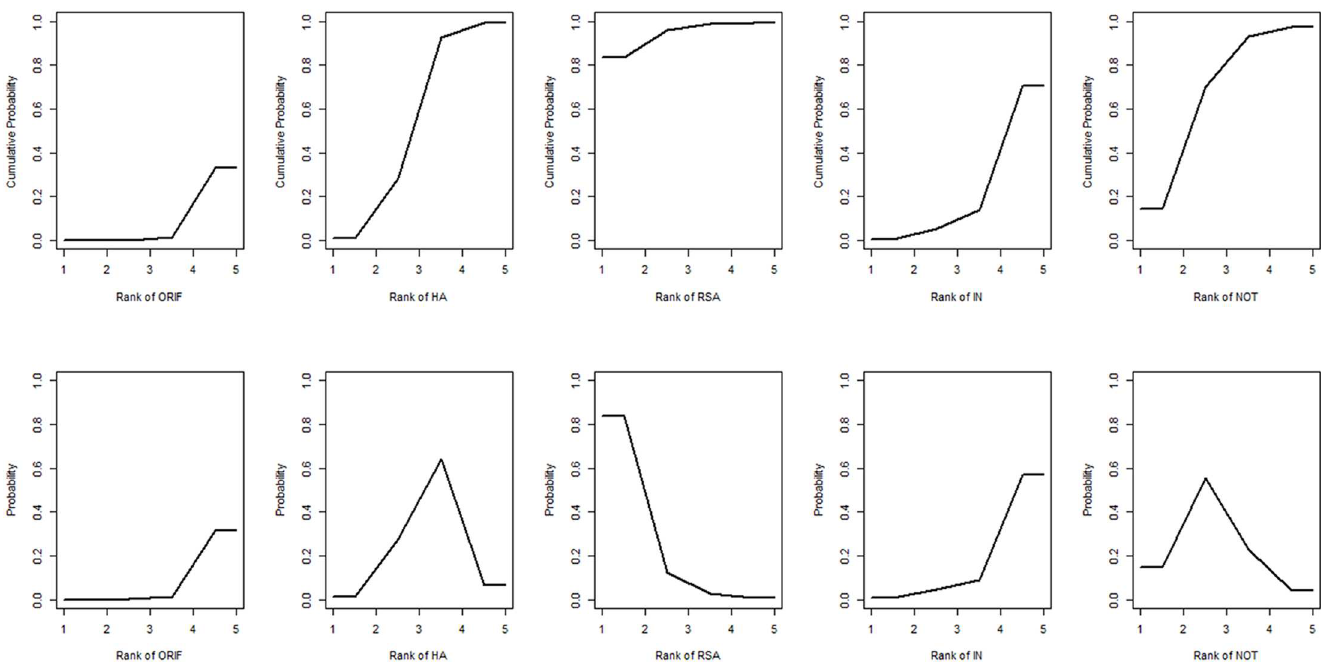
Fig 8. Ranking of treatment strategies based on the probability of their effects on the outcome of incidence of additional surgery. ORIF: open reduction and internalfixation; HA: hemiarthroplasty; RSA: reverse shoulderarthroplasty; IN: intramedullary nailing;NOT: Non-operative